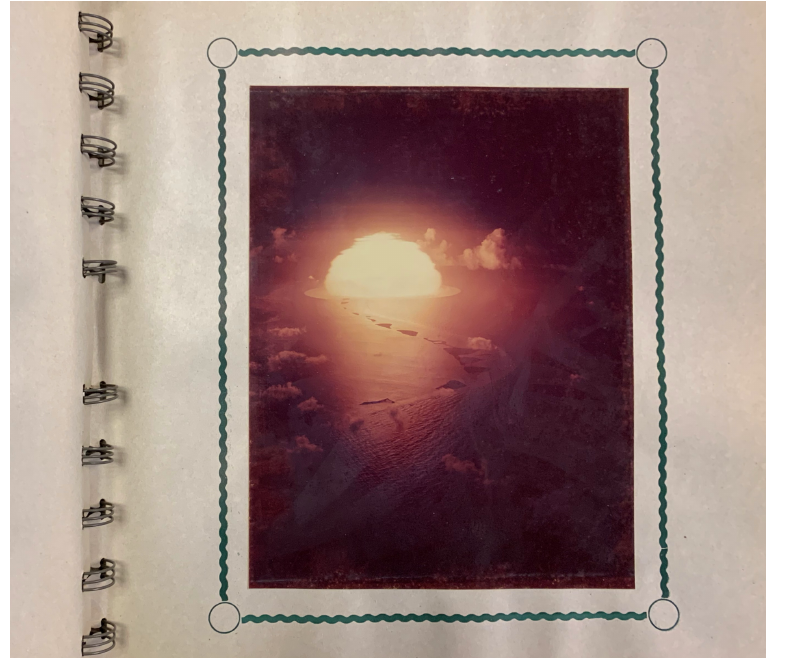
Figure 5: Concluding page from Operation Greenhouse photo album, 1951. Image courtesy of the Rare Book & Manuscript Library, University of Illinois at